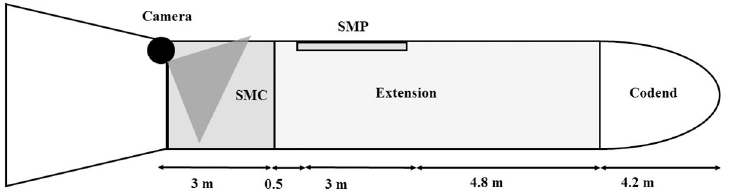
Fig 1. Schematic drawing of of the experimental extension and codend. The black circle represents the video camera and the grey triangle its field of view. SMC: Square mesh cylinder; SMP: Square mesh panel.